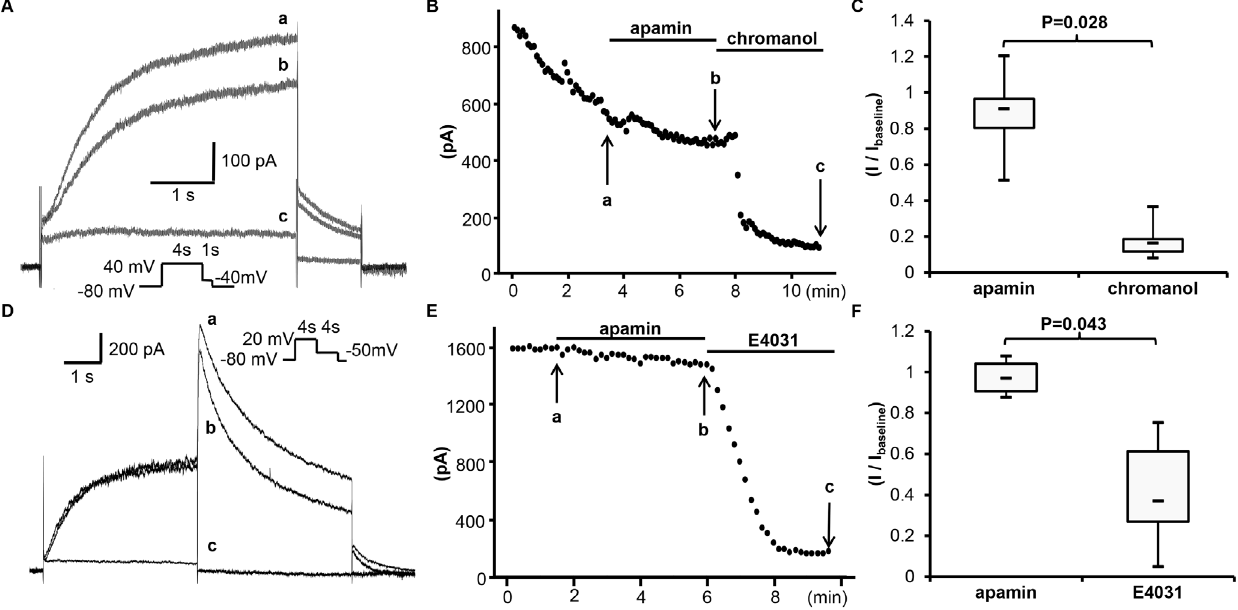
Figure 5. Effects of apamin on I Ks and I Kr in transfected HEK 293 cells. (A) The representative tracings of I Ks obtained by pulse protocol shown in the inset before apamin (a), after apamin (b) and after chromanol (c) at time points indicated by arrows a through c, respectively, in (B). (B) The time course of peak I Ks at 40 mV. (C) The summary of drug effects normalized to baseline. (D) The representative tracings of I Kr obtained by a pulse protocol shown in the inset before apamin (a), after apamin (b) and after E4031 (c) at time points indicated by arrows a through c in (E). (E) The time course of peak I Kr at 20 mV. (F) The summary of drug effects normalized to baseline.